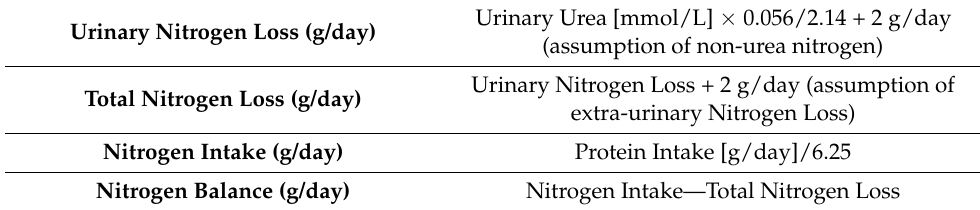
Table 1. Methods for calculation of urinary nitrogen loss and nitrogen balance